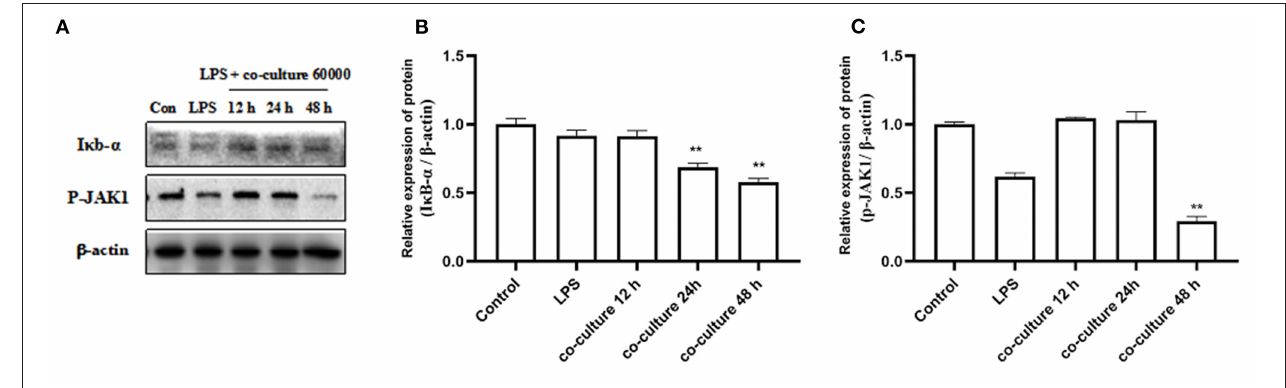
FIGURE 5 | Expression of inflammation related proteins. bEECs were treated with 0.1 µ g/mL LPSs for 6h, co-cultured with bAD-MSCs 60 000 cells for 12, 24, and 48h. (A) Western blot analysis of I κ B- α and P-JAK1 proteins. (B) Relative expression levels of I κ B- α protein. (C) Relative expression levels of P-JAK1 protein. Significance is indicated by ** P < 0.01.